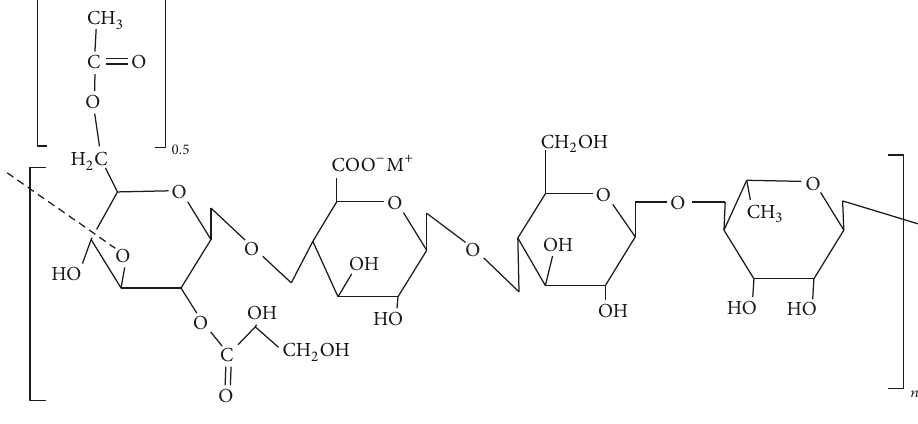
Figure 1: Chemical structure of